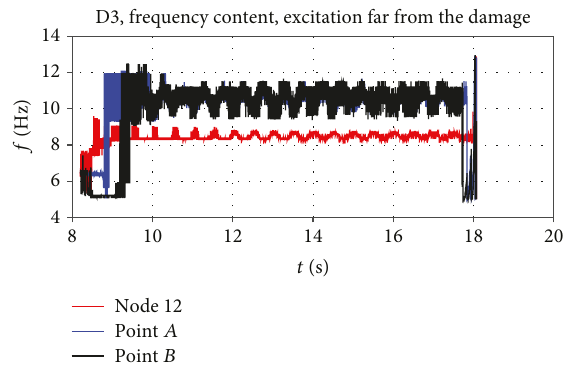
Figure 63: D3, maximum frequency, excitation far from the damage.